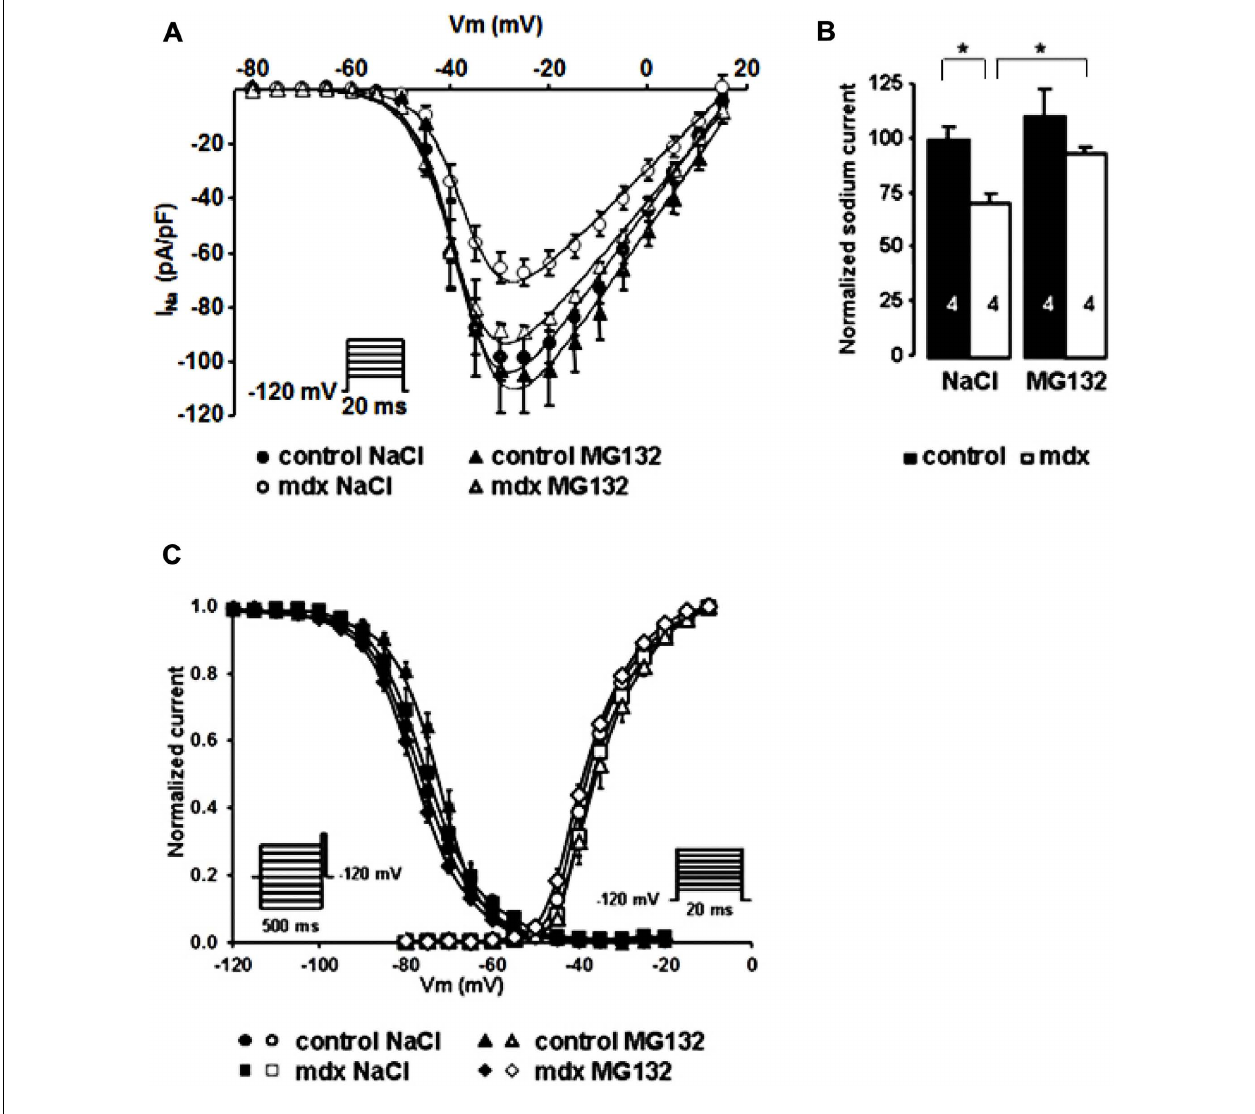
The “normalized current” represents the maximum current density recorded at a given voltage ( − 25 mV). (C) Steady-state activation and inactivation curves.The protocol is indicated in inset.The number of mice used for quantification is indicated in the bars. Results are expressed as normalized mean signal intensity. * P < 0.05, n.s. not